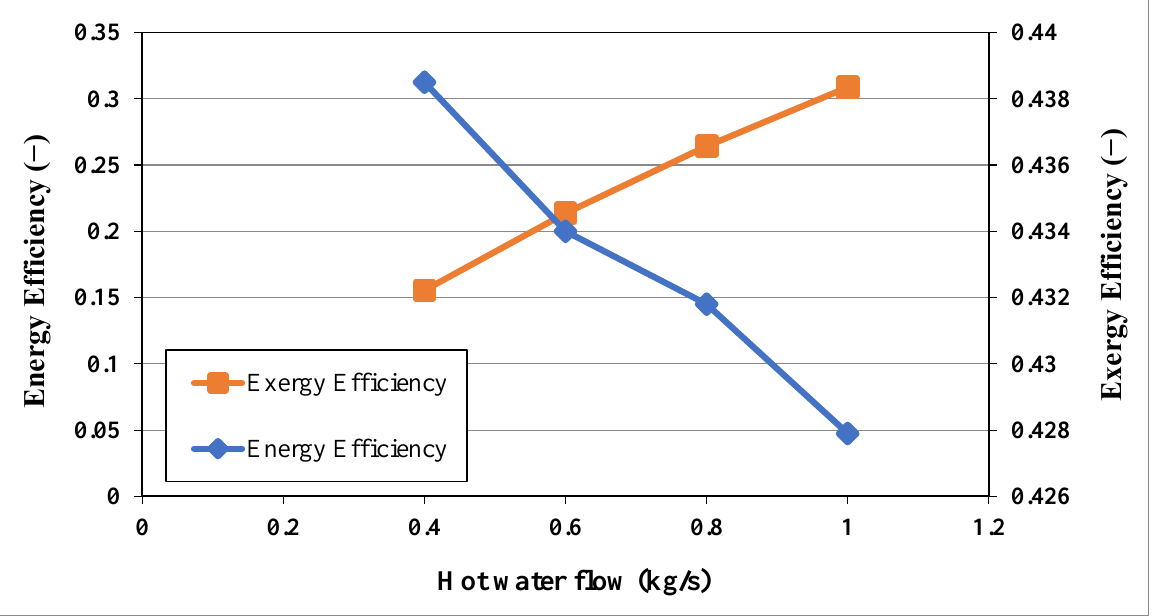
Figure 7. Energy and exergy efficiencies versus ambient temperature.